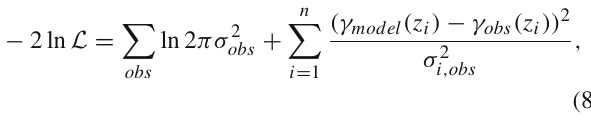
Fig. 3 Reconstructed γ( z ) as a function of z . The blue line represents the best GP reconstructed fit for the SPT-SZ data along with the 1 σ error band (shown by blue shaded region). The red band shows the NR simulation results at R 500 from [21] by assuming the Eq. (1)